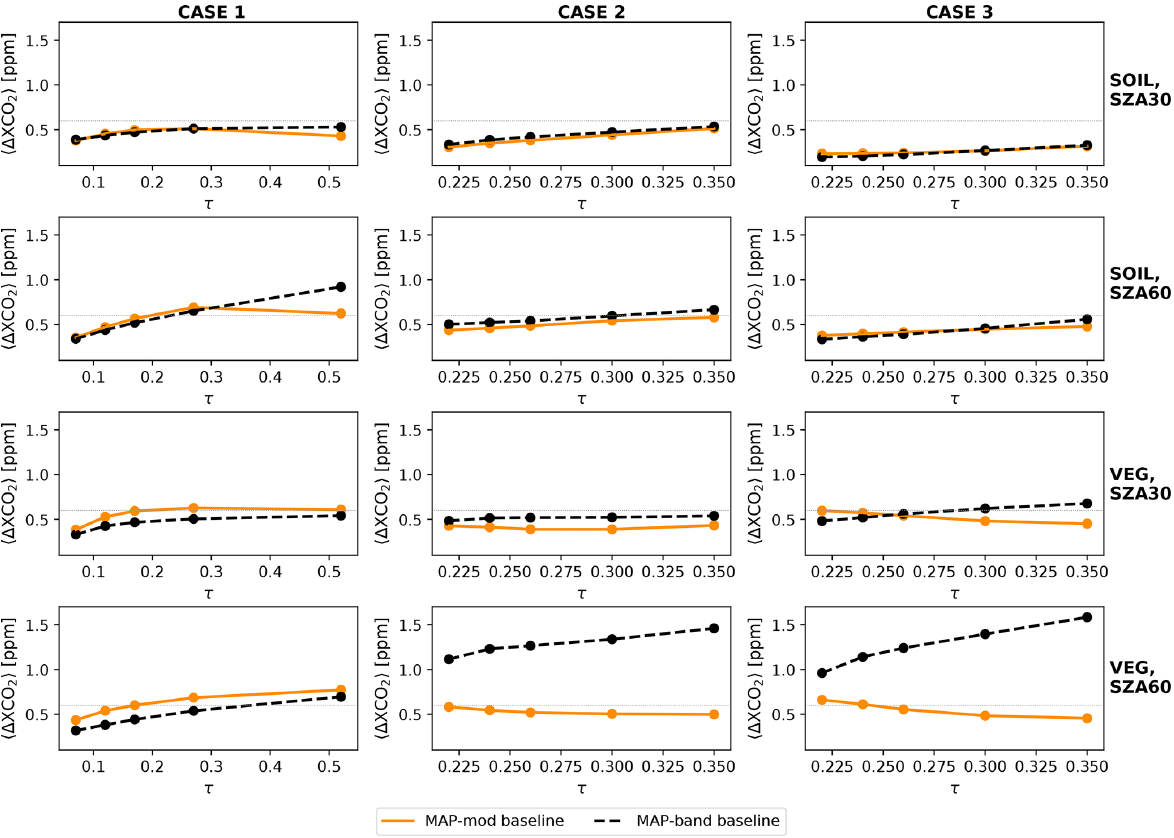
Figure 6. (cid:104) (cid:49) XCO 2 (cid:105) as a function of total aerosol optical depth at 765nm. The two lines in each panel represent the baseline setups of MAP-mod (orange, solid) and MAP-band (black, dashed).